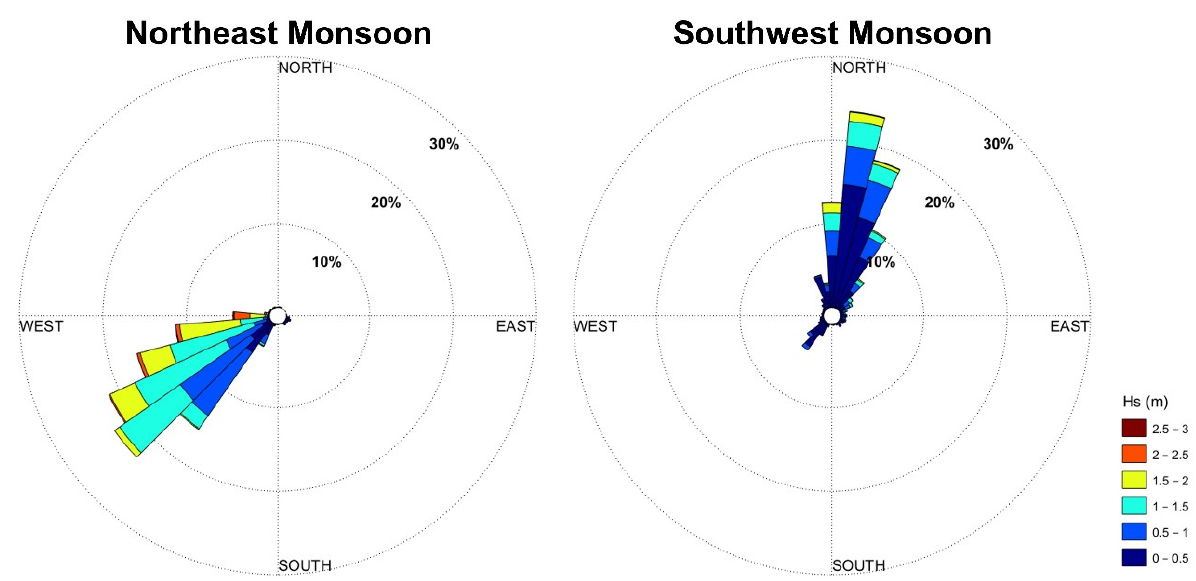
Figure 11. Compass rose of H s and D p during the northeast and southwest monsoons.